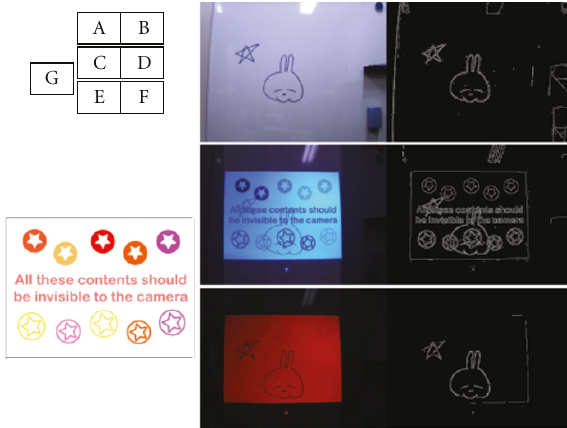
Figure 9: (A) is an environment seen by the normal camera. (C) and (E) show environment (A) as seen by the normal camera and the synchronized camera (according to the nonintrusive projection), respectively, while (G) is being projected from the projector. (B), (D), and (F) are Canny edge detection results of (A), (C), and (E), respectively.